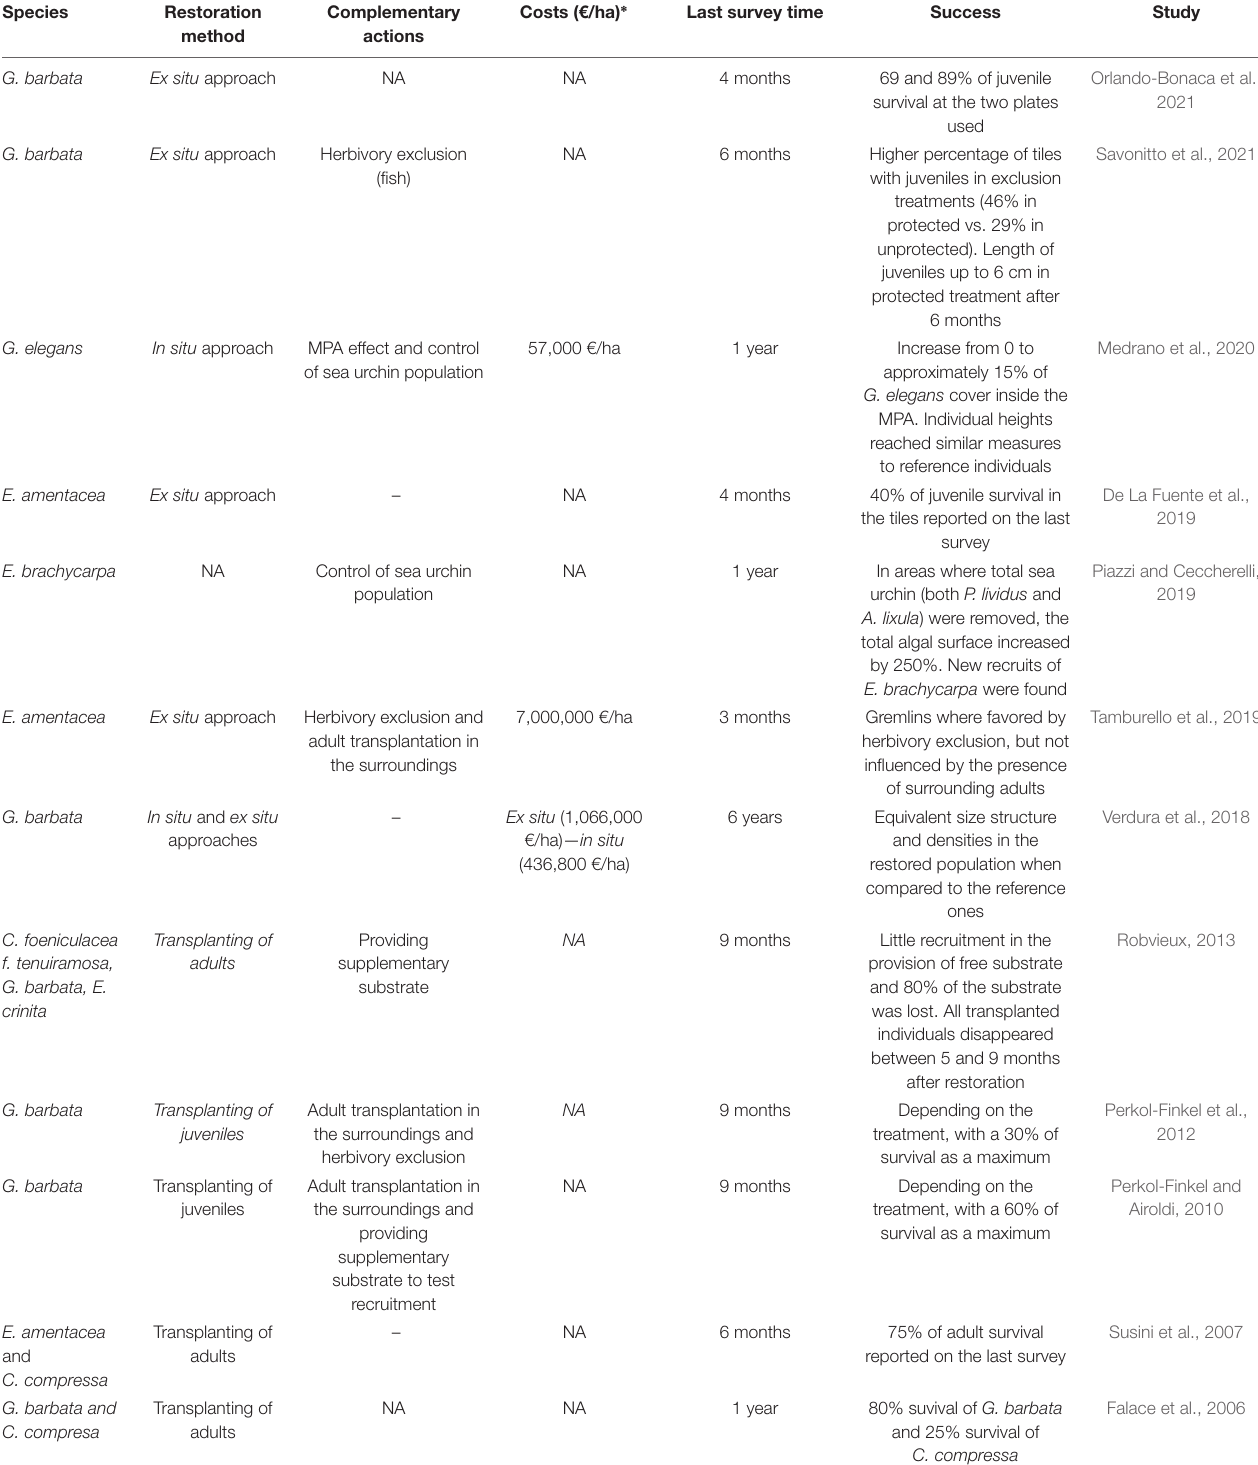
TABLE 1 | Available studies reporting restoration methods for Cystoseira s.l. species in the Mediterranean (using at least one method described in this study).